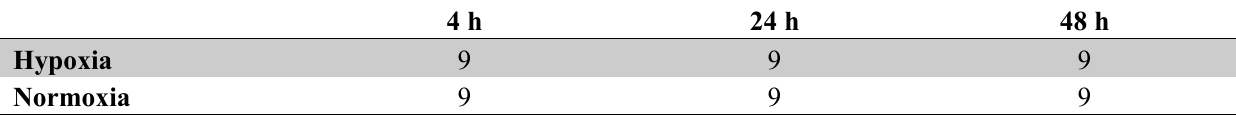
Table 3. Number of samples in each